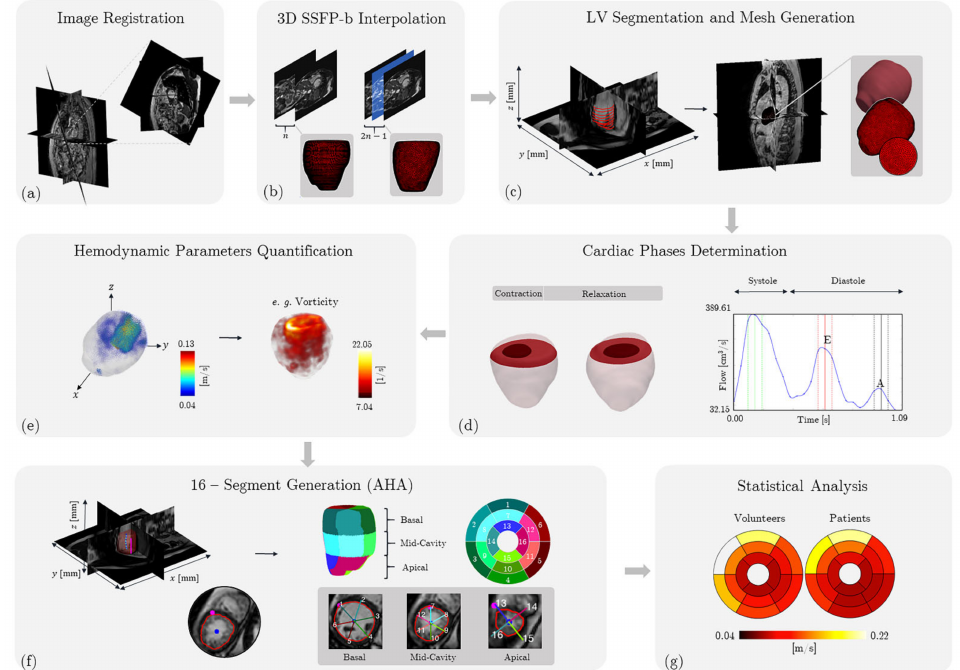
Figure 1. Schematic description of the quantification process. ( a ) First, we performed registration of the 4D Flow with the b-SSFP images. ( b ) Second, we doubled the number of slices in the b-SSFP images, ( c ) then the LV segmentation and tetrahedral mesh were generated. ( d ) We estimated the cardiac phases under study ( e ) and we transferred the velocity information at each node of the mesh from the 4D Flow MRI datasets using cubic interpolation. ( f ) Then, we calculated hemodynamic parameters under study. ( g ) Finally, the mean values of hemodynamic parameters were included in a bullseye plot to compare volunteers and DCM